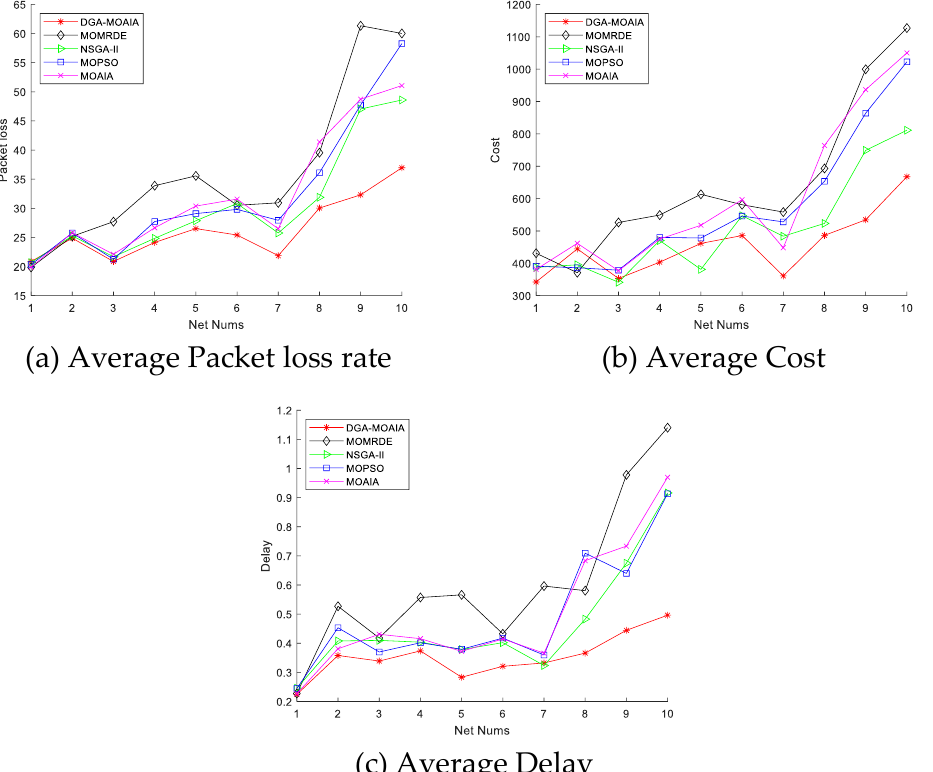
Figure 9. The comparison of average transmission delay, average transmission cost, and average packet loss